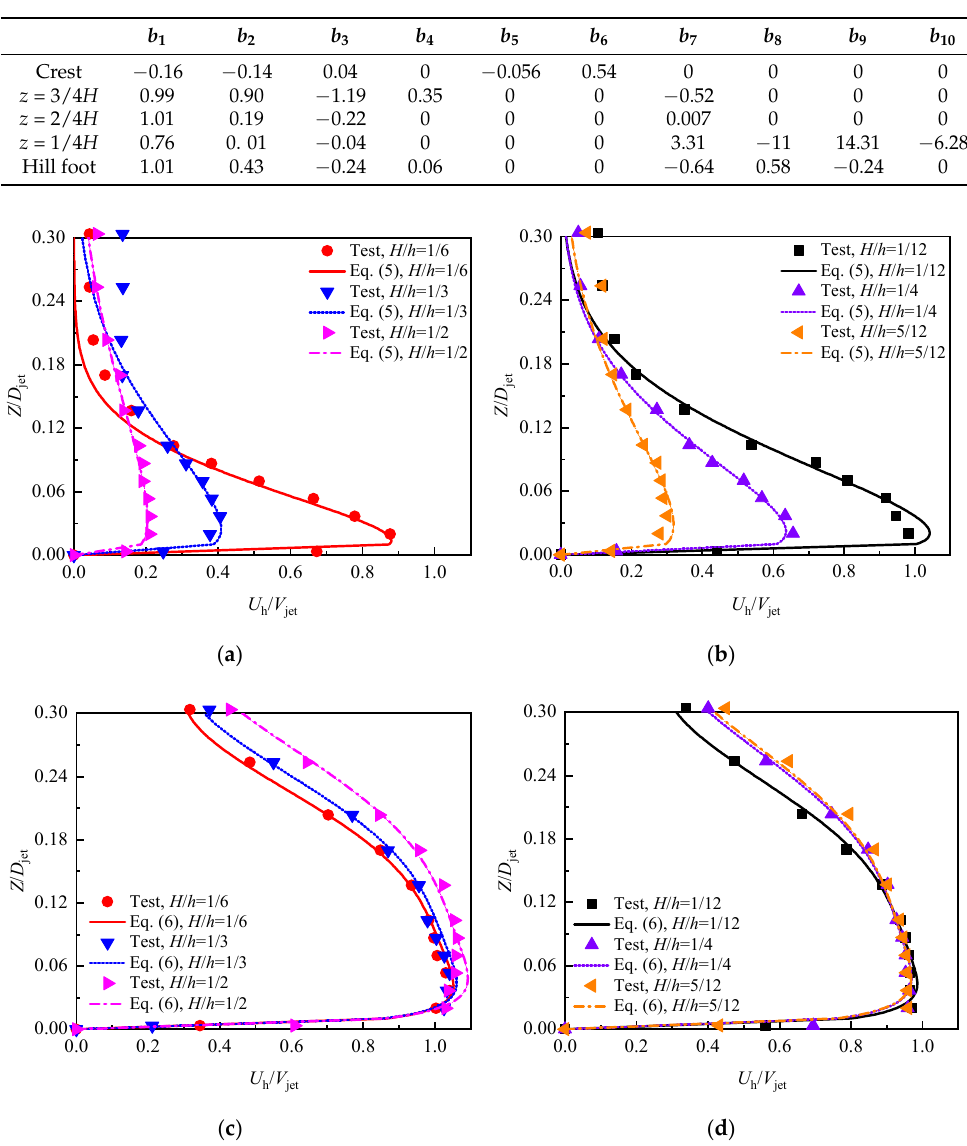
Table 5. Values of a i.